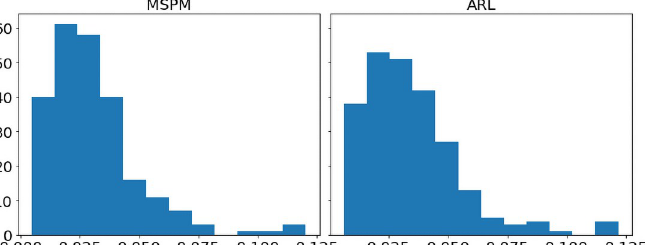
Fig 9. For portfolio(a), histograms of MSPM and ARL’s 5-day RstdDRR depict right-skewed distributions.